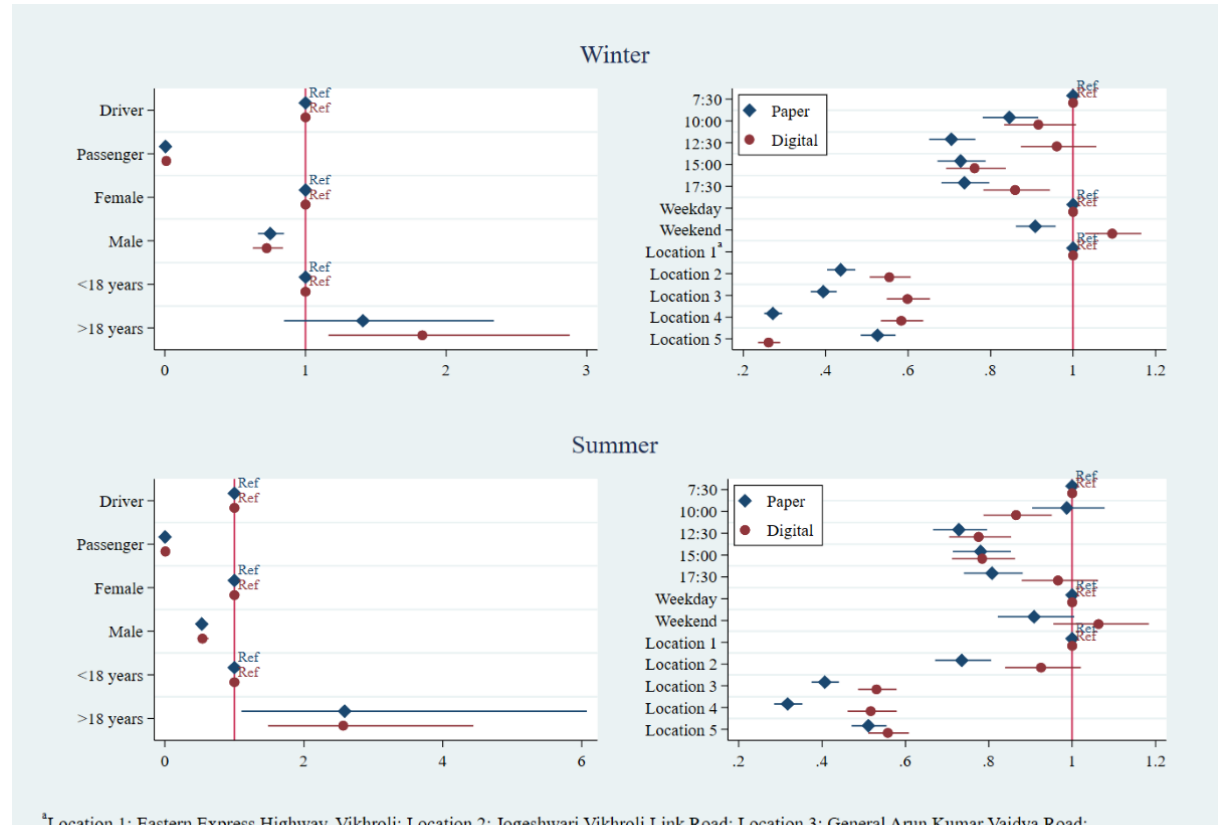
Figure 4. Correct helmet use: adjusted odds ratios by data collection method and